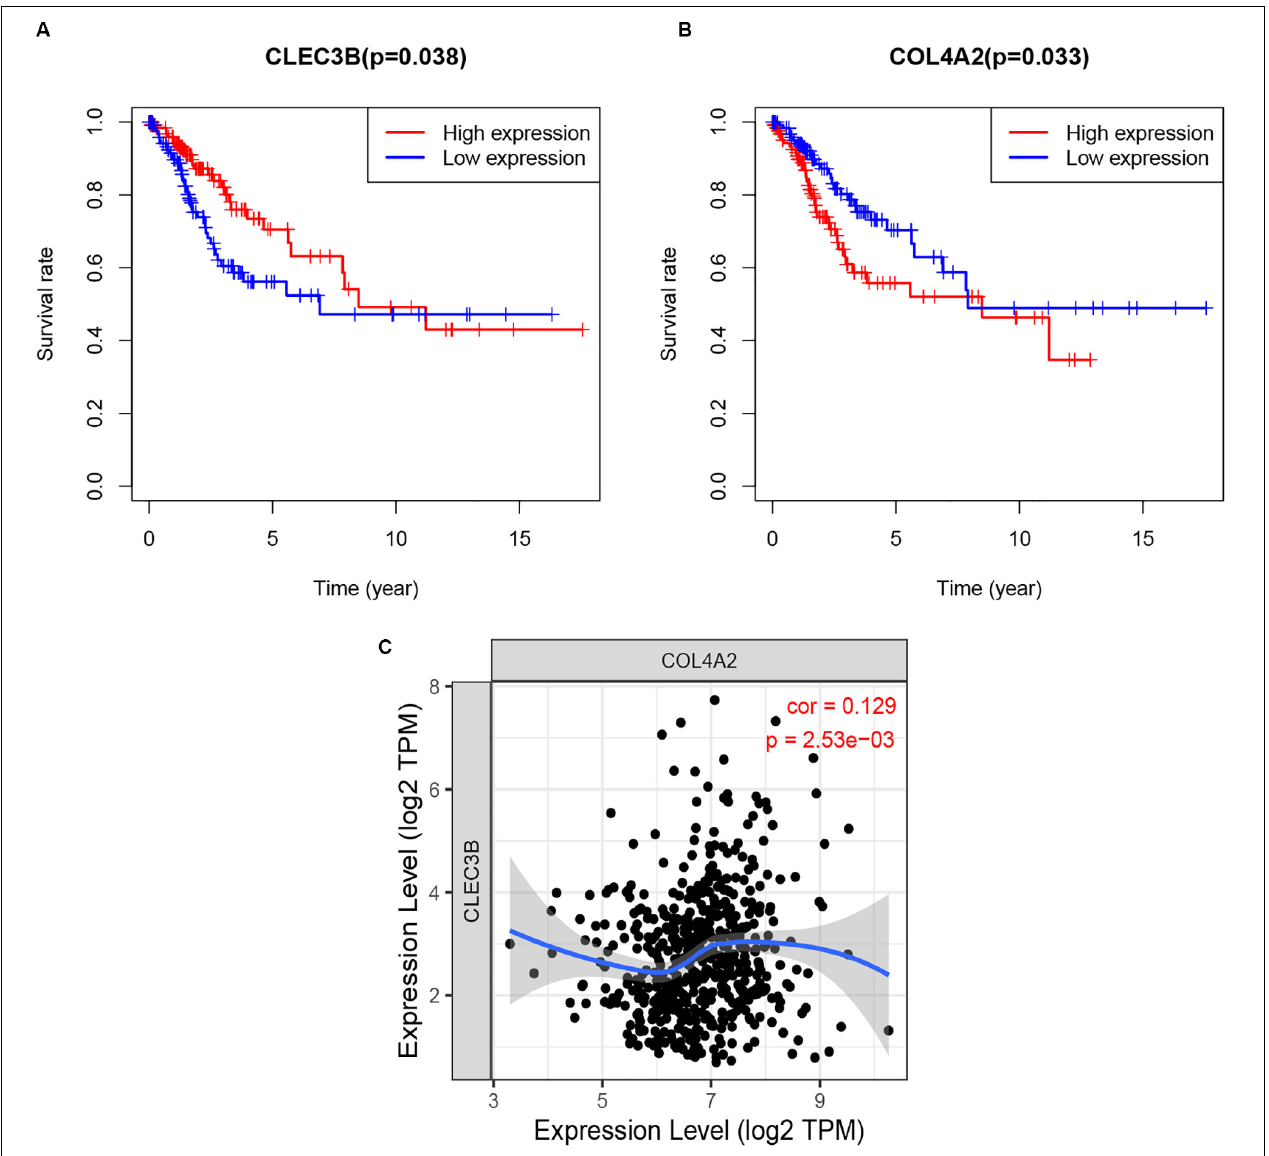
FIGURE 9 | Survival analysis (A,B) and correlation analysis (C) of two hub TMB-related immune genes with p -value. TMB, tumor mutation